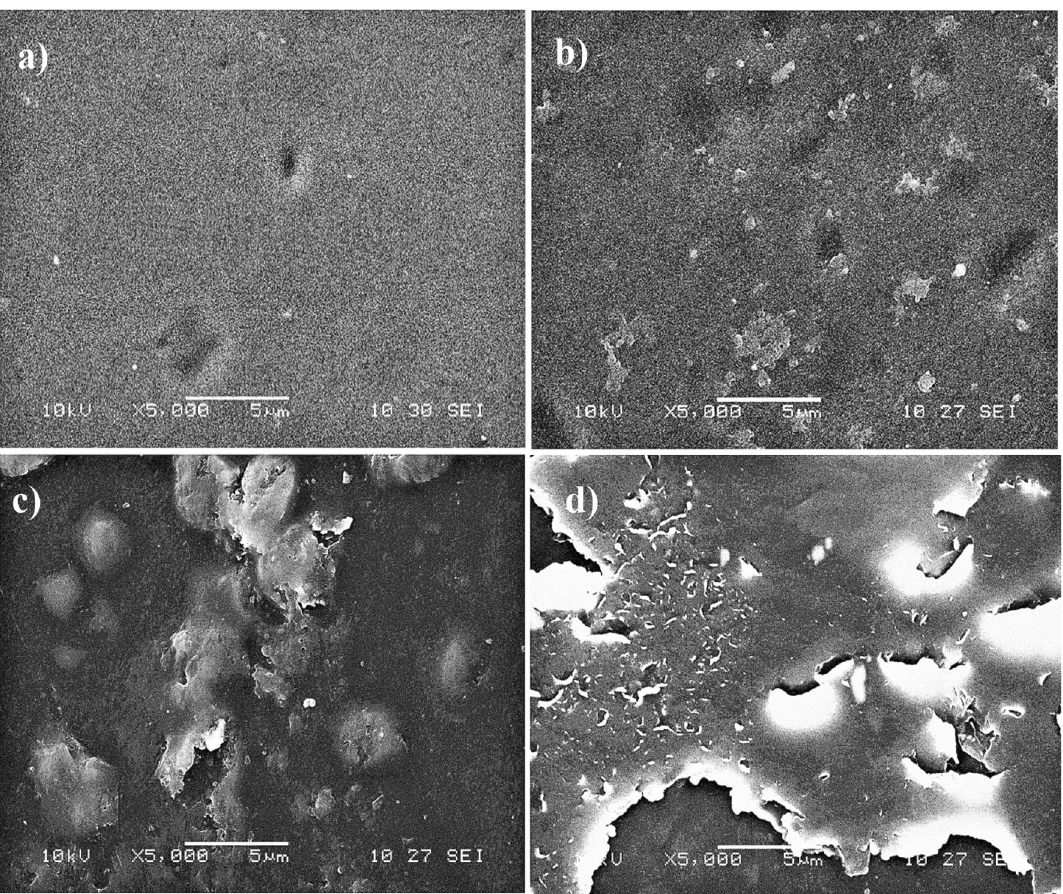
Figure 7. SEM pictures of hydrobhobising agents treated cellulose-APP composite ( a ) before surface treatment, after treatment with ( b ) E2CA, ( c ) TOS in ethanol and ( d ) TOS in toluene. Surface treatment Elastic modulus at 20% RH